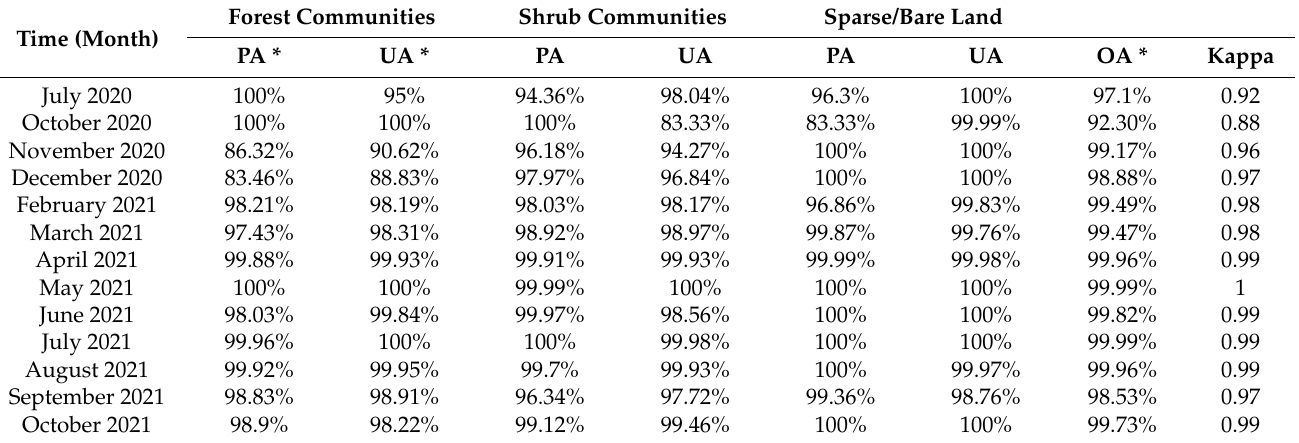
Table 5. Accuracy assessment and statistics for monitoring vegetation community regeneration